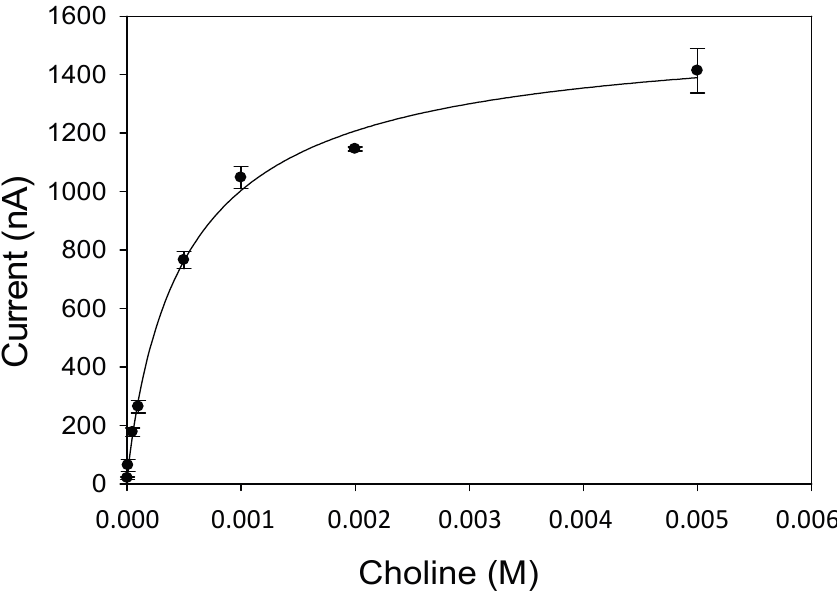
Figure 3. Choline calibration plot. Choline oxidase concentration: 180 mU/mL; applied potential: − 50 mV vs. Ag/AgCl; 0.05 M phosphate buffer + 0.1 M KCl, pH 7.4. Measurements were carried out in